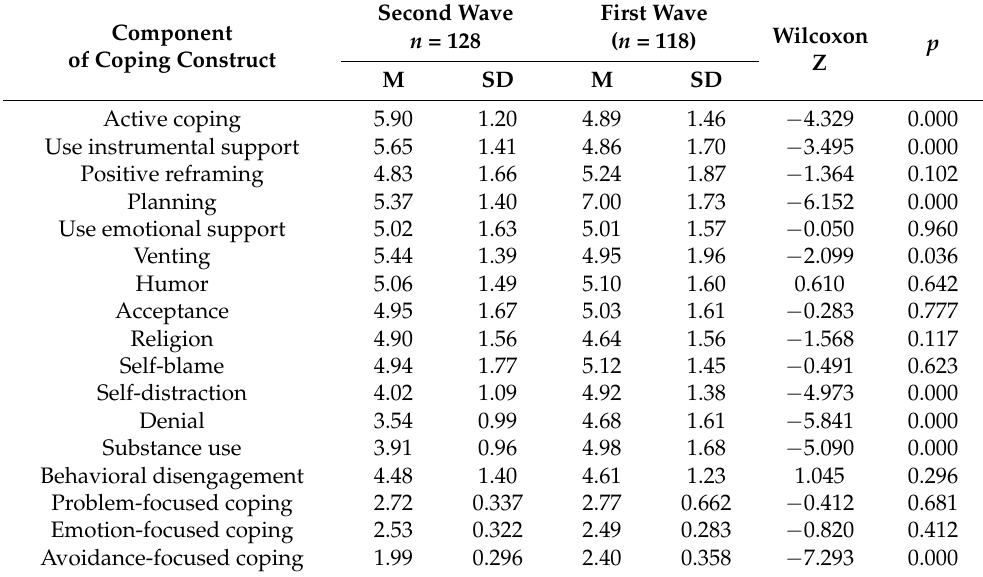
Table 3. Estimations of components of coping after the first and second